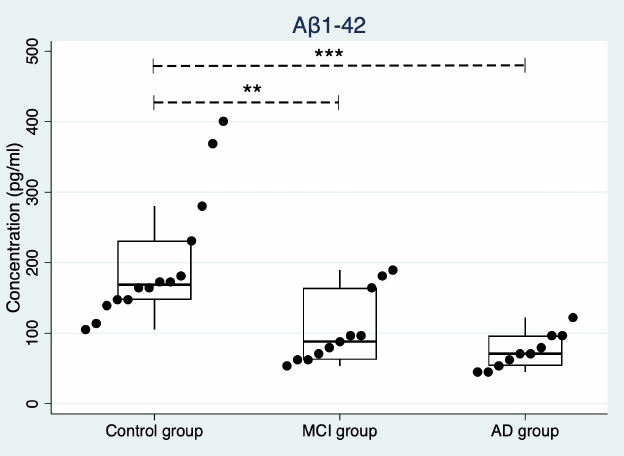
Figure 3. Strip plot showing the concentration of p-tau in the control group, in prodromal AD (MCI), and in mild-to-moderate AD. Boxes specify medians and quartiles, vertical spikes represent the largest or smallest value within the IQR of the upper or lower quartile. MCI: mild cognitive impairment due to Alzheimer’s disease, AD: Alzheimer’s disease. Regarding the estimation of APP-CTF fragments, Western blot evaluation revealed the presence of a predominant immunoreactive band, with a molecular weight of approxi- mately 25 kDa. Notably, the detection of 25 kDa CTF fragments was already observed in CSF from AD patients [9]. In this context, we performed a densitometric analysis of the 25 kDa CTF and we found a significant difference between groups as determined by one-way ANOVA (F(2,32) = 7.95, p = 0.002). A Tukey post hoc test highlighted that APP-CTF was